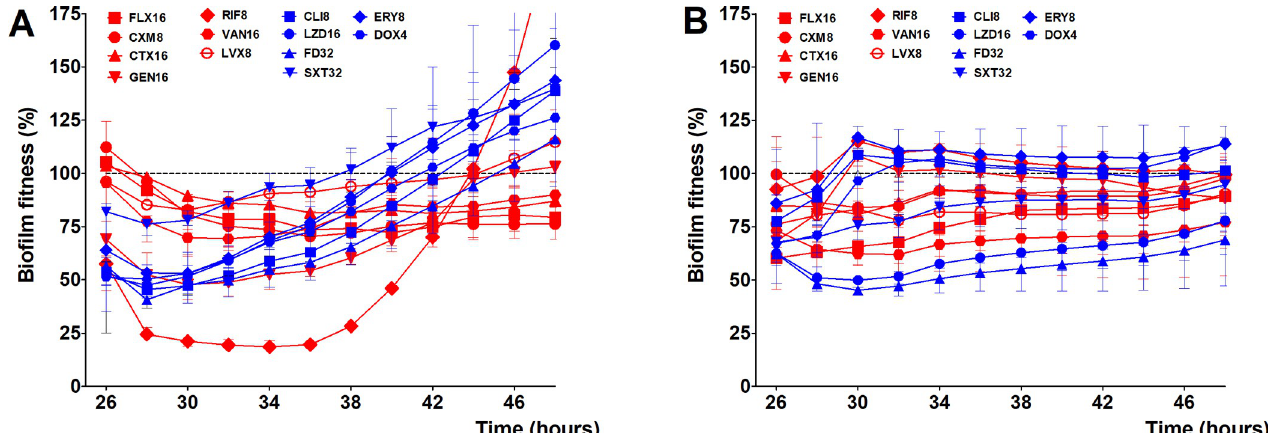
Fig 6. Staphylococcus aureus biofilm sensitivity to other antibiotics. The 24 hours kinetic of biofilm fitness of MSSA CC15 (A) and MRSA Mu50 (CC5) (B) strains co-incubated with maximum serum concentration of several bactericide (red) and bacteriostatic (blue) antibiotics relative to untreated biofilm fitness. Dashed horizontal lines indicate control (untreated biofilm). Error bars represent median with range (n = 3).